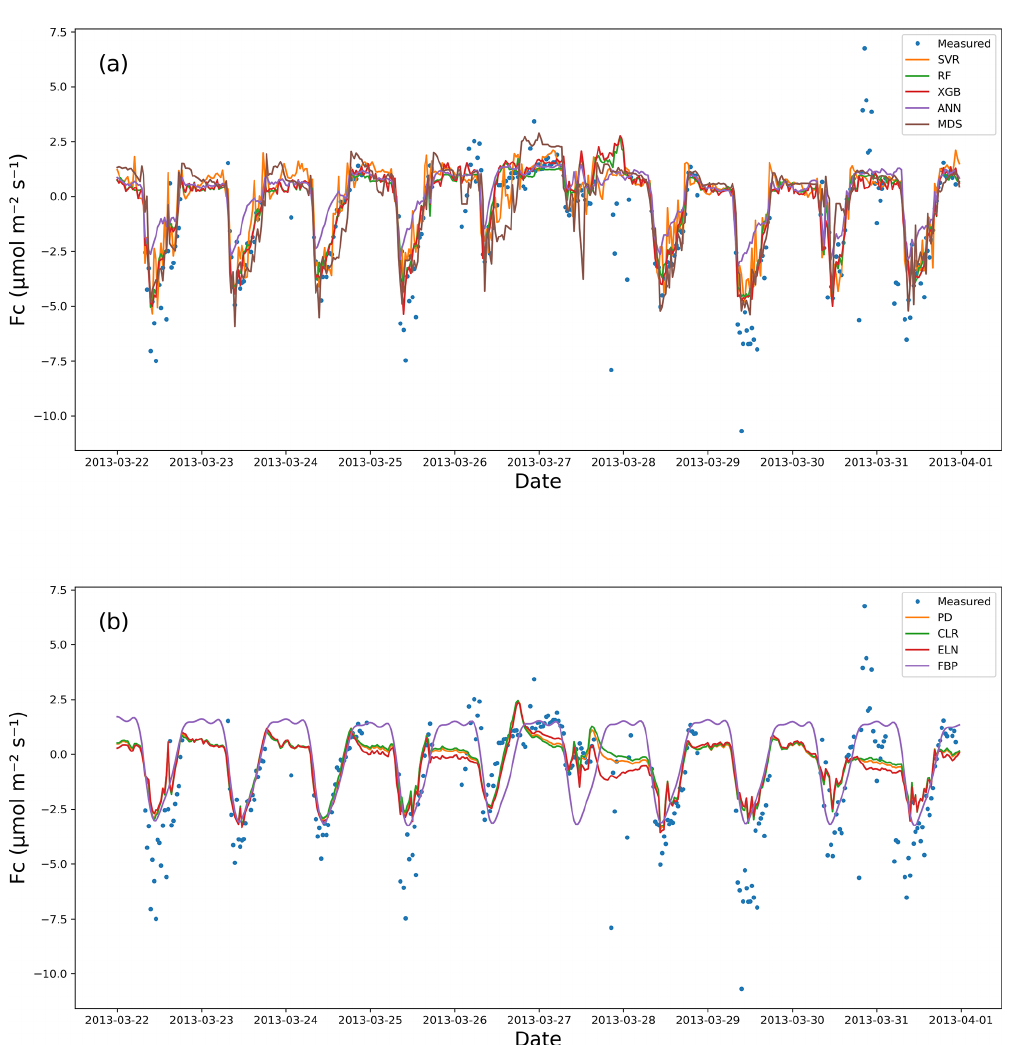
Figure 2. Measured vs. estimated values of F c for Calperum based on a 10d gap window (22–31 March 2013): (a) the ML algorithm plus the MDS and (b) the linear models plus